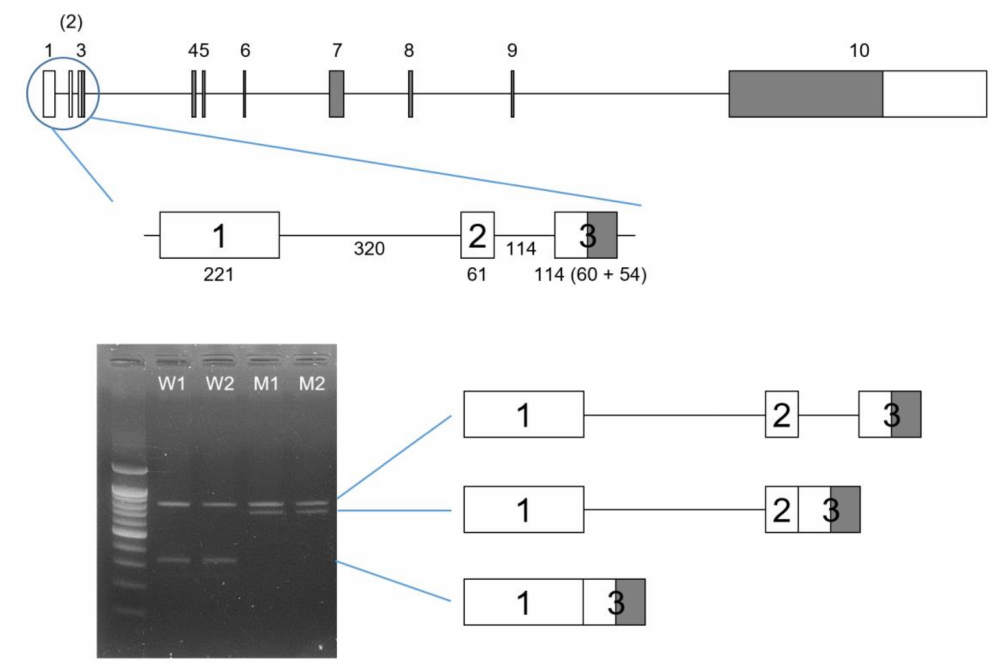
Figure 2. Gene structure diagram of ENAM . The boxes indicate the exons, and the lines connecting boxes are the introns. Grey areas in the boxes indicate coding regions, and white areas in the boxes indicate noncoding regions. The exon numbers are shown above the boxes, and the skipped exon 2 is shown in parentheses. Nucleotide numbers are shown below the boxes and the lines in the enlarged diagram that show exons 1 to 3. Exon 3 has 60 noncoding and 54 coding nucleotides. The agarose gel image shows the result of the splicing assay. Wild-type (W1 and W2) vectors resulted in two bands (800 bp upper and 324 bp lower band), while mutant (M1 and M2) vectors resulted in two differently-sized bands (800 bp upper and 705 bp lower band). The common 800 bp upper band was the pre-mRNA sequence. The 324 bp small band was the normal splicing transcript with exon 1 and 3. The 705 bp band was the mutant transcript, including exon 1, intron 1, exon 2 and exon 3. W: wild-type, M: